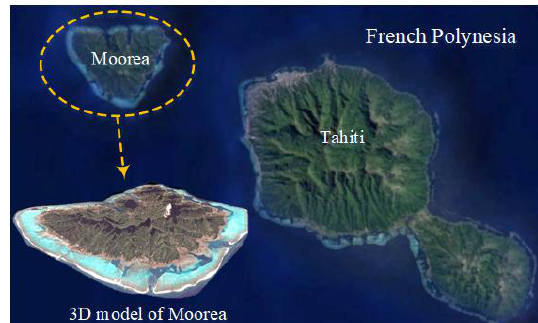
Figure 2 . A 3D model and satellite imagery map of Moorea.